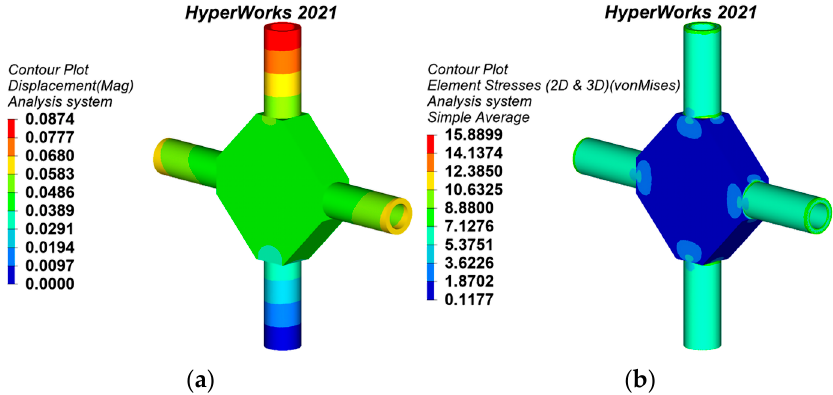
Figure 11. Static analysis results of the flat polygon cross joint: ( a ) displacement nephogram, ( b ) equivalent stress nephogram.